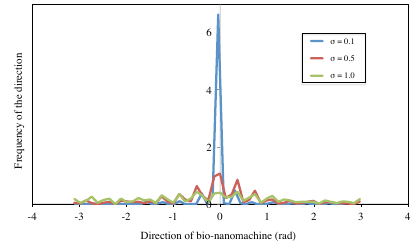
Figure 2: Impact of noise on moving directions Impact of noise on mutual information